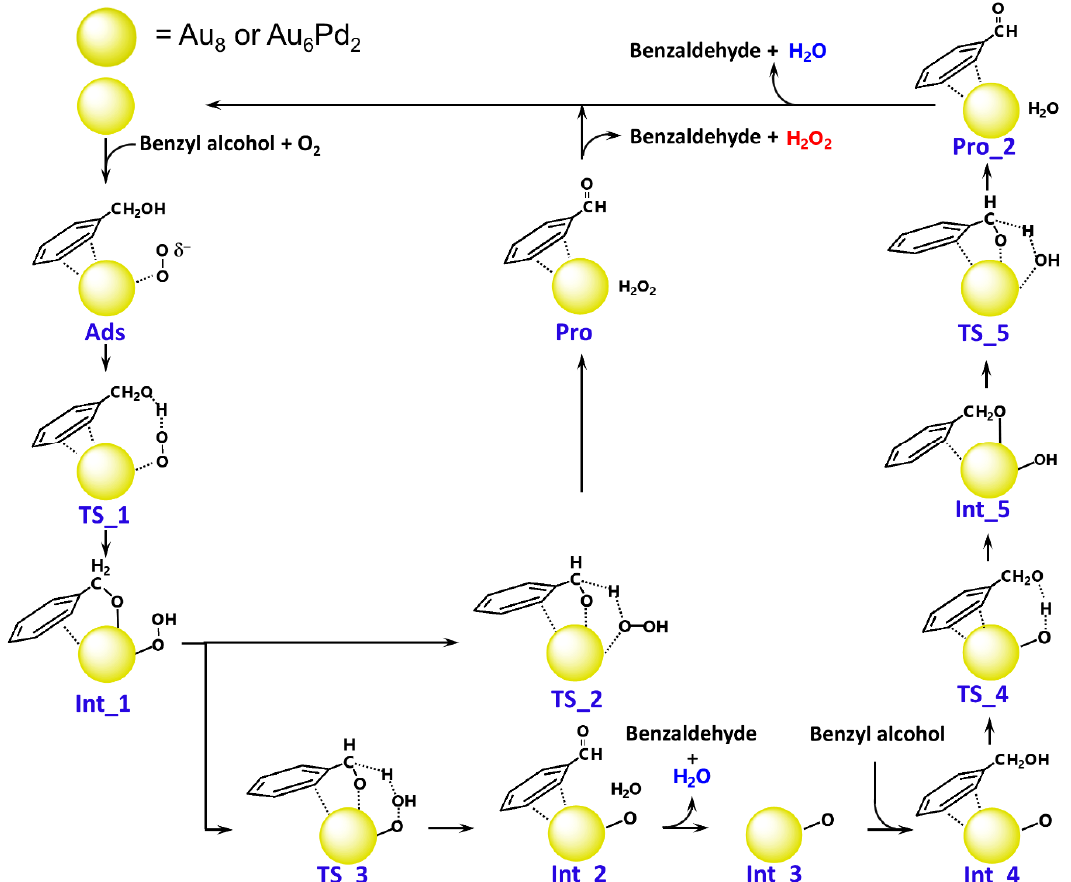
Figure 3 . Catalytic cycle of the aerobic oxidation of benzyl alcohol to benzaldehyde over Au 8 and Au 6 Pd 2 .